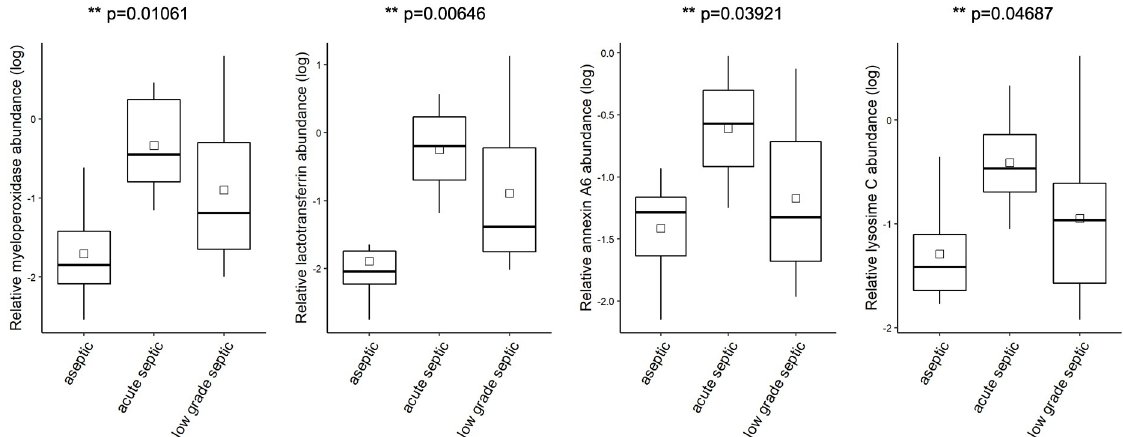
Fig 9. The relative abundances (log) of the myeloperoxidase, lactotransferrin, annexin A6 and lysozyme C. All proteins were found in a significantly higher concentration in the acute and low-grade septic group than in the sterile group. (myeloperoxidase p = 0.01061, lactotransferrin p = 0.00646, annexin A6 p = 0.03921, lysozyme C p = 0.04687) ANOVA test.